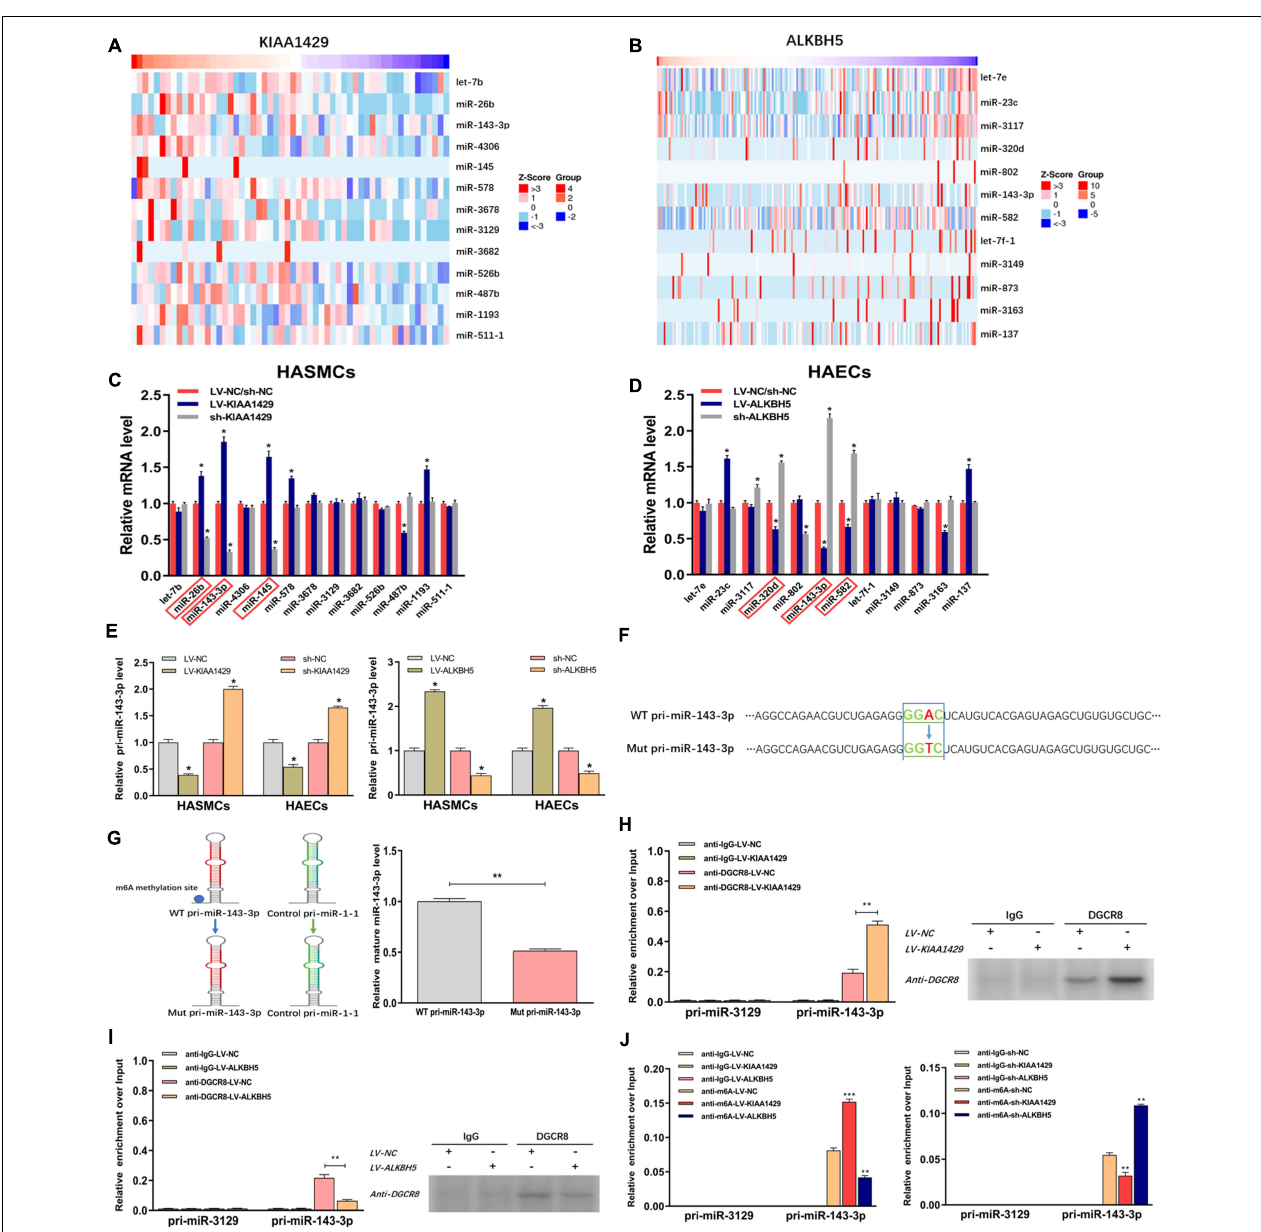
FIGURE 5 | KIAA1429 and ALKBH5 oppositely regulate the processing of miR-143-3p via m6A modification. (A,B) Through searching in the LinkedOmics database, we found 13 miRNAs positively associated in expression with KIAA1429 and 12 miRNAs negatively associated with ALKBH5. (C) The levels of miR-26b, miR-143-3p, and miR-145 increased when KIAA1429 was overexpressed and decreased when KIAA1429 was silenced. (D) The levels of miR-320d, miR-143-3p, and miR-582 were negatively regulated by ALKBH5. (E) The unprocessed pri-miRNA-143-3p was accumulated in KIAA1429-knockdown or ALKBH5-overexpression cells and significantly decreased in KIAA1429-overexpression or ALKBH5-silence cells. (F) In one reporter, the adenosine [A] of the RRACH m6A sequence motif located in the pri-miR-143-3p region outside the pre-miR-143-3p sequence was mutated to thymidine [T]. (G) The mutation of the RRACH m6A motif in pri-miR-143-3p significantly reduced its processing to the mature form. (H,I) The levels of pri-miR-143-3p bound to DGCR8 were significantly enhanced or reduced by overexpression of KIAA1429 or ALKBH5, respectively. (J) MeRIP assay showed that overexpressing KIAA1429 or silencing ALKBH5 notably increased the quantity of pri-miR-143-3p modified by m6A. Data are presented as the mean ± SEM ( N ≥ 3 per group); * p < 0.05, ** p < 0.01, and *** p <